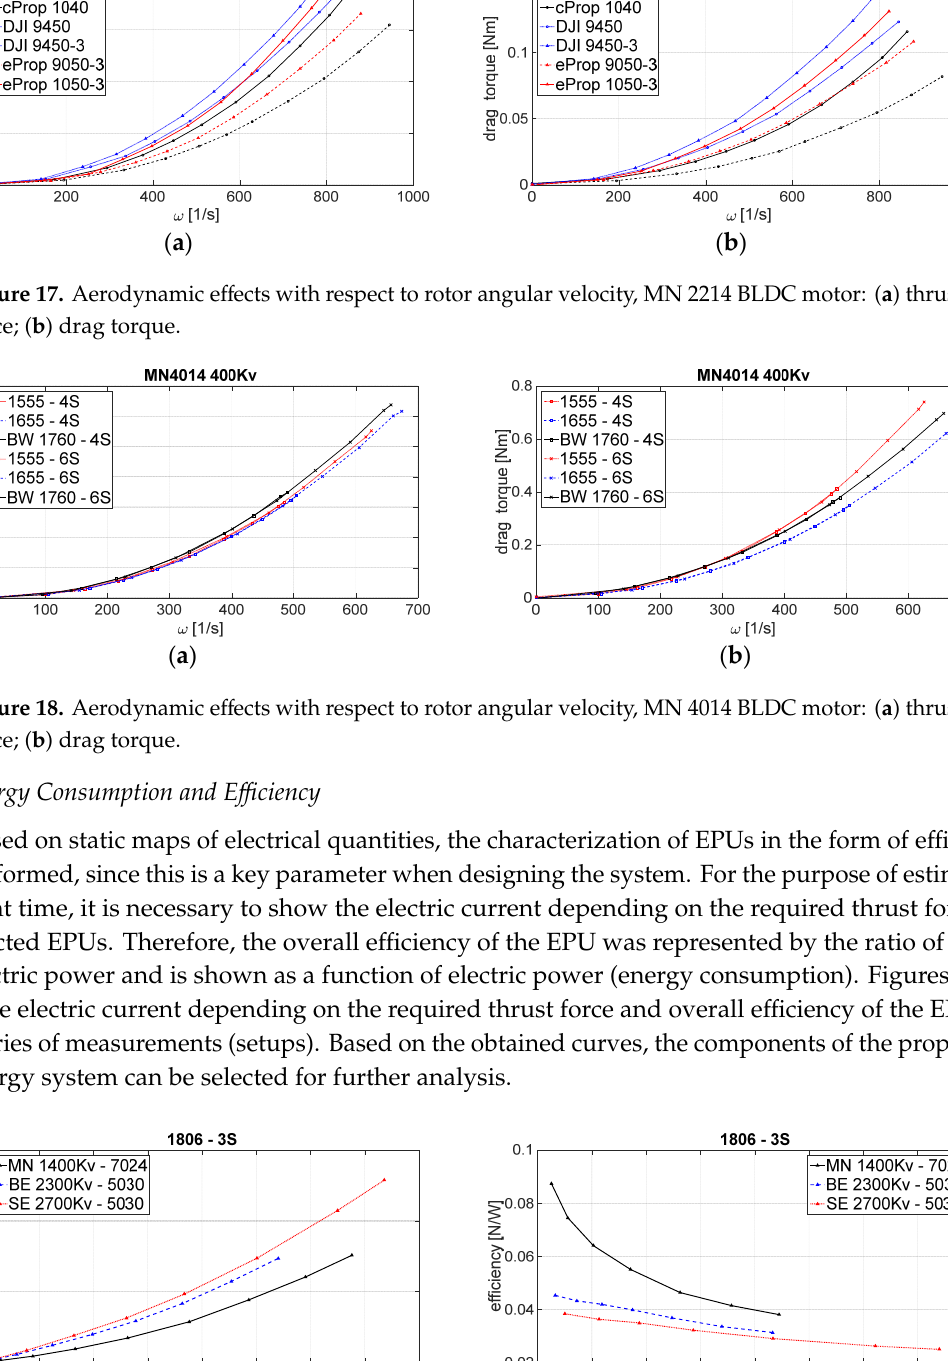
( b ) Figure 20. Energy consumption of MN 2214 BLDC motor: ( a ) electric current with respect to thrust force; ( b ) overall efficiency. ( a ) ( b ) Figure 21. Energy consumption of MN 4014 BLDC motor: ( a ) electric current with respect to thrust force; ( b ) overall efficiency. 4.3. Electric Propulsion System Comparison By comparing the EPUs selected on the basis of efficiency for individual EPU setups, it is possible to select the electric propulsion system parameters for a specific aircraft purpose. Figure 22 shows the overall efficiency of the selected EPU where it can be seen that the higher power EPUs have a higher degree of overall efficiency. Figure 23 shows the thrust force with respect to the rotor angular velocity for the selected EPU setups based on experimental measurements and specifications from the EPU manufacturer.